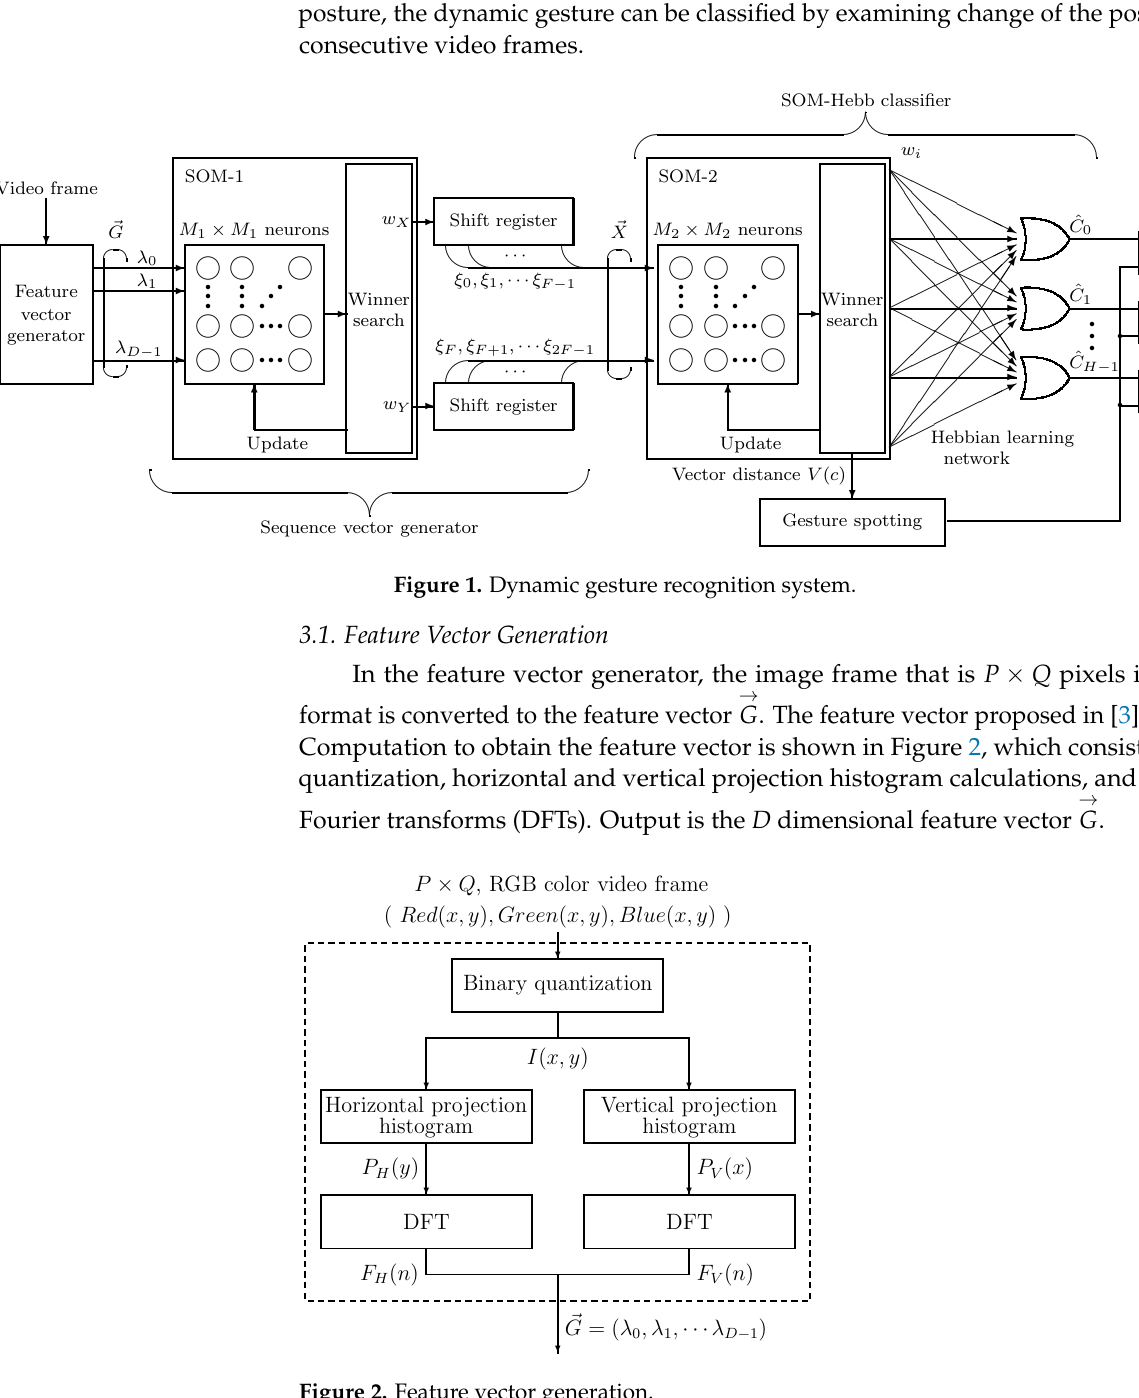
Figure 2. Feature vector generation.